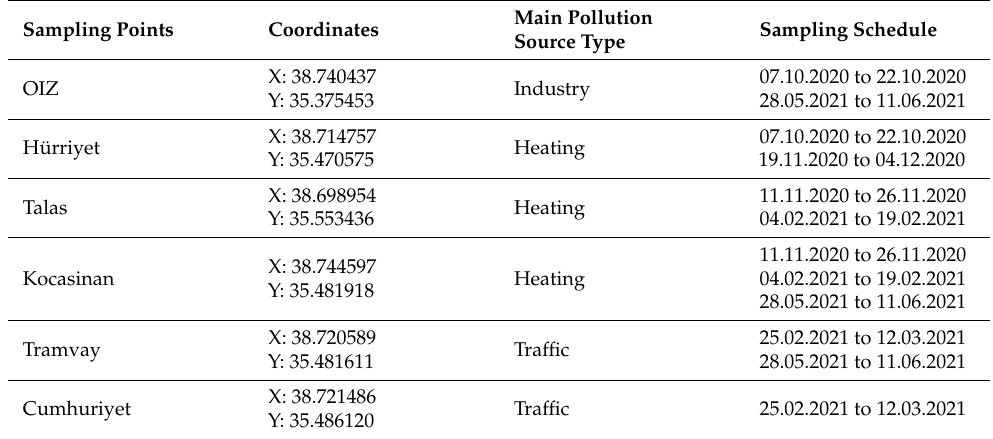
Table 1. Coordinates of the sampling points, pollution source types, and the sampling schedule. Sampling Points